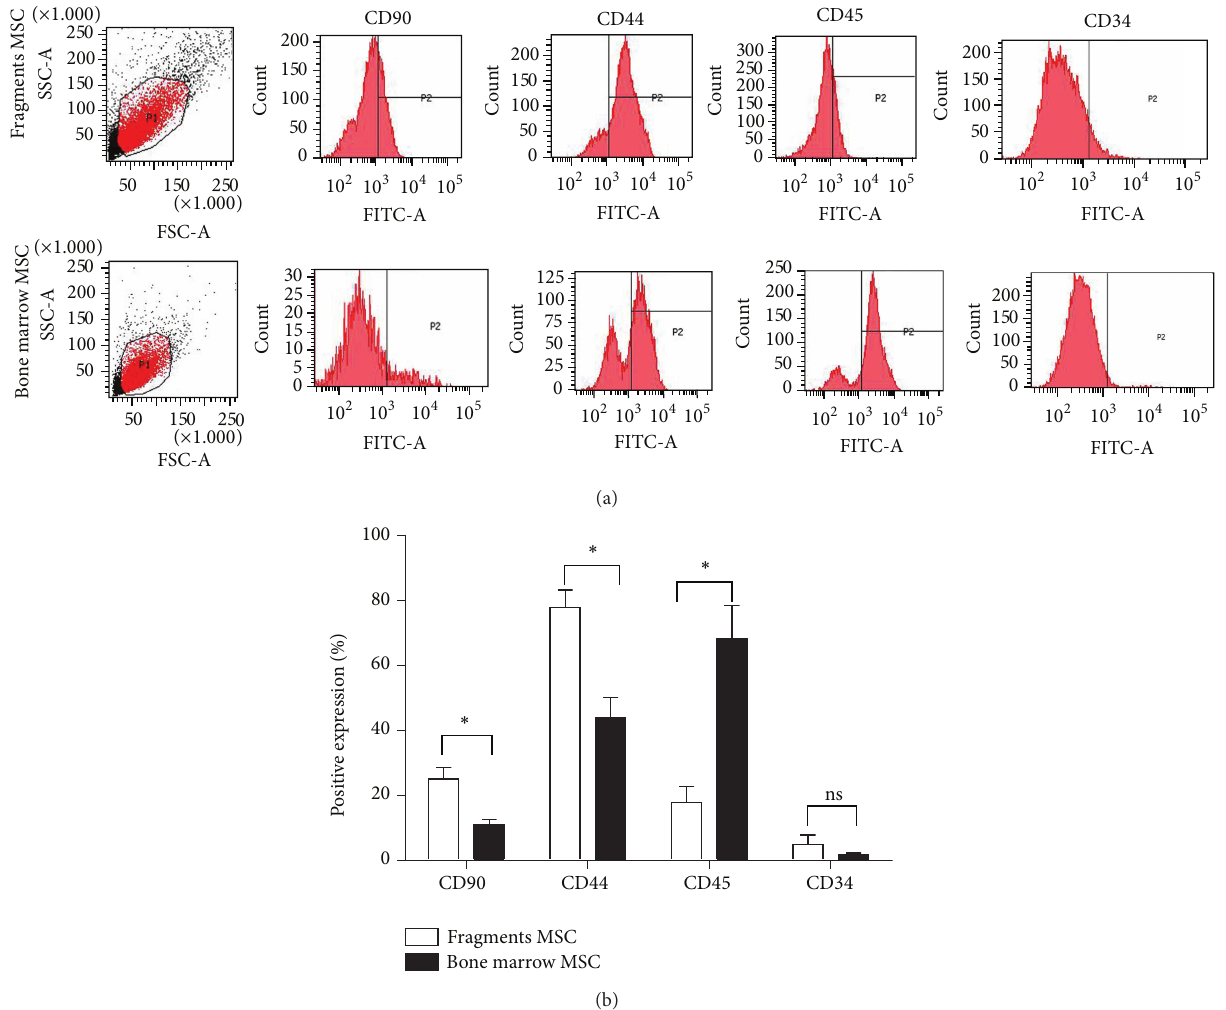
Figure 4: Cell immunophenotypes of the first passage from cultured bone marrow and bone fragments. (a) Representative images of CD90, CD44, CD45, and CD34 expressions. (b) Surface immunophenotype analyses. ∗ 𝑃 < 0.05 , ns, 𝑃 ≥ 0.05